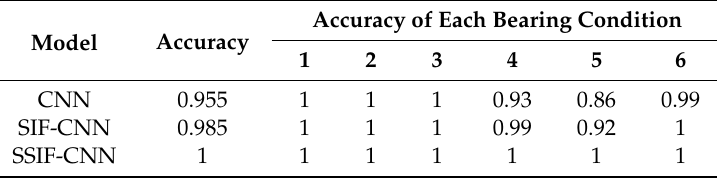
Figure 12. Accuracy of the different CNNs with iterations. Table 12. The classification accuracy of the training samples.